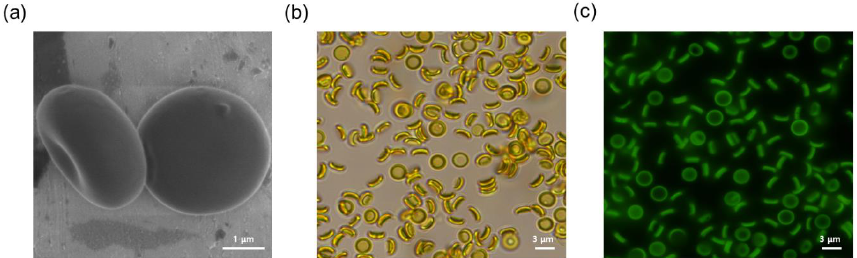
Figure 1. ( a ) Scanning electron micrograph of Cur-PLGA-DPPs. Imaging of Cur-PLGA-DPPs through ( b ) bright-field microscopy, and ( c ) fluorescence microscopy.